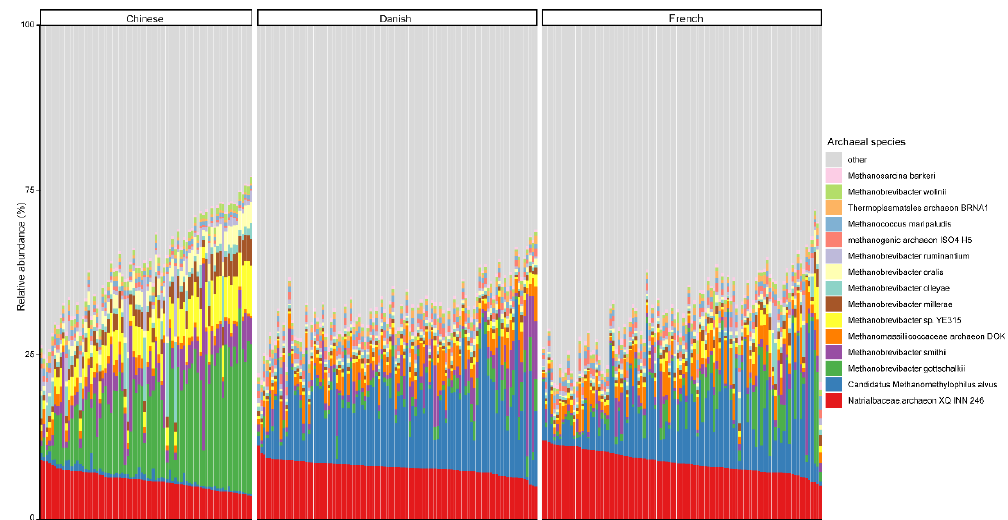
Figure 3. Relative abundance of the top 15 archaeal species in swine fecal samples from different countries. Each column represents one pig, and each color represents one archaeal species. The y -axis represents relative abundance ranging from 0 to 100%.